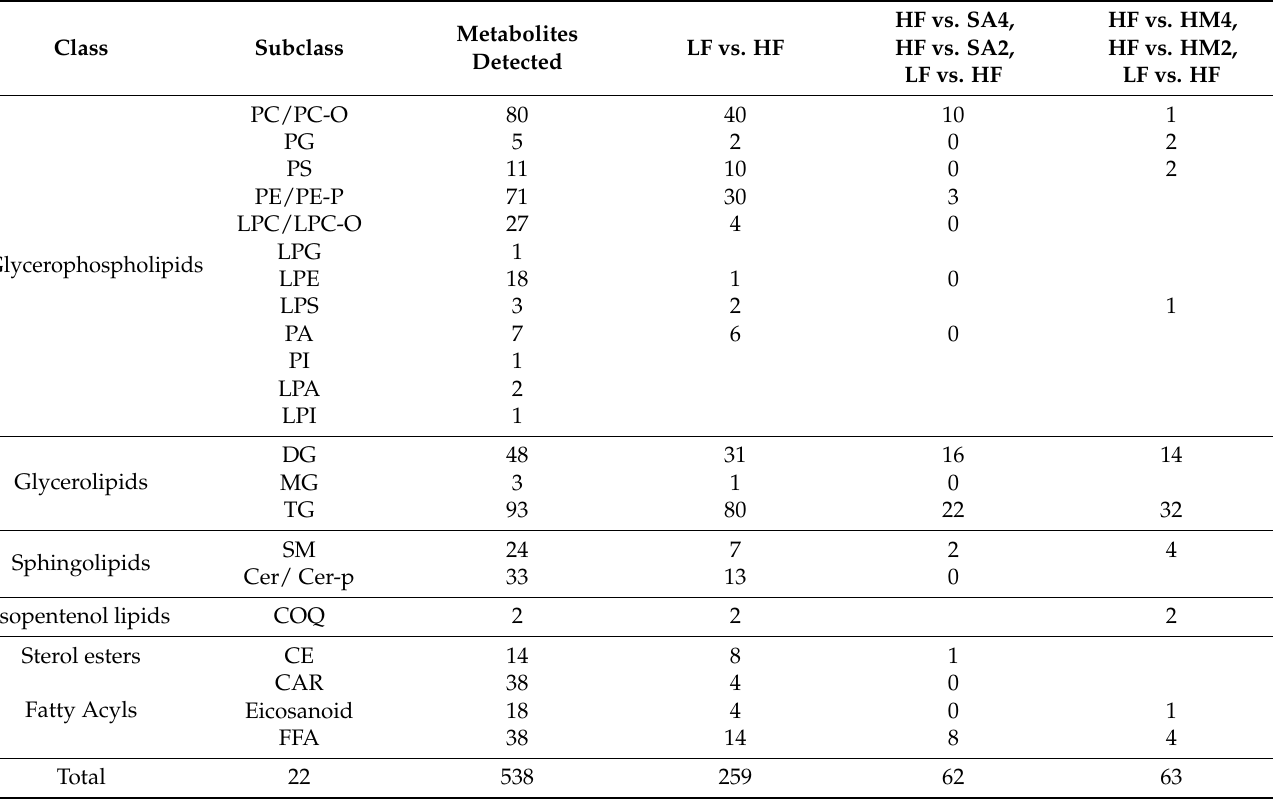
Table 4. Lipid species of metabolites in colonic contents of mice in the LF group, the HF group, the HM2 group, the HM4 group, the SA2 group, and the SA4 group.